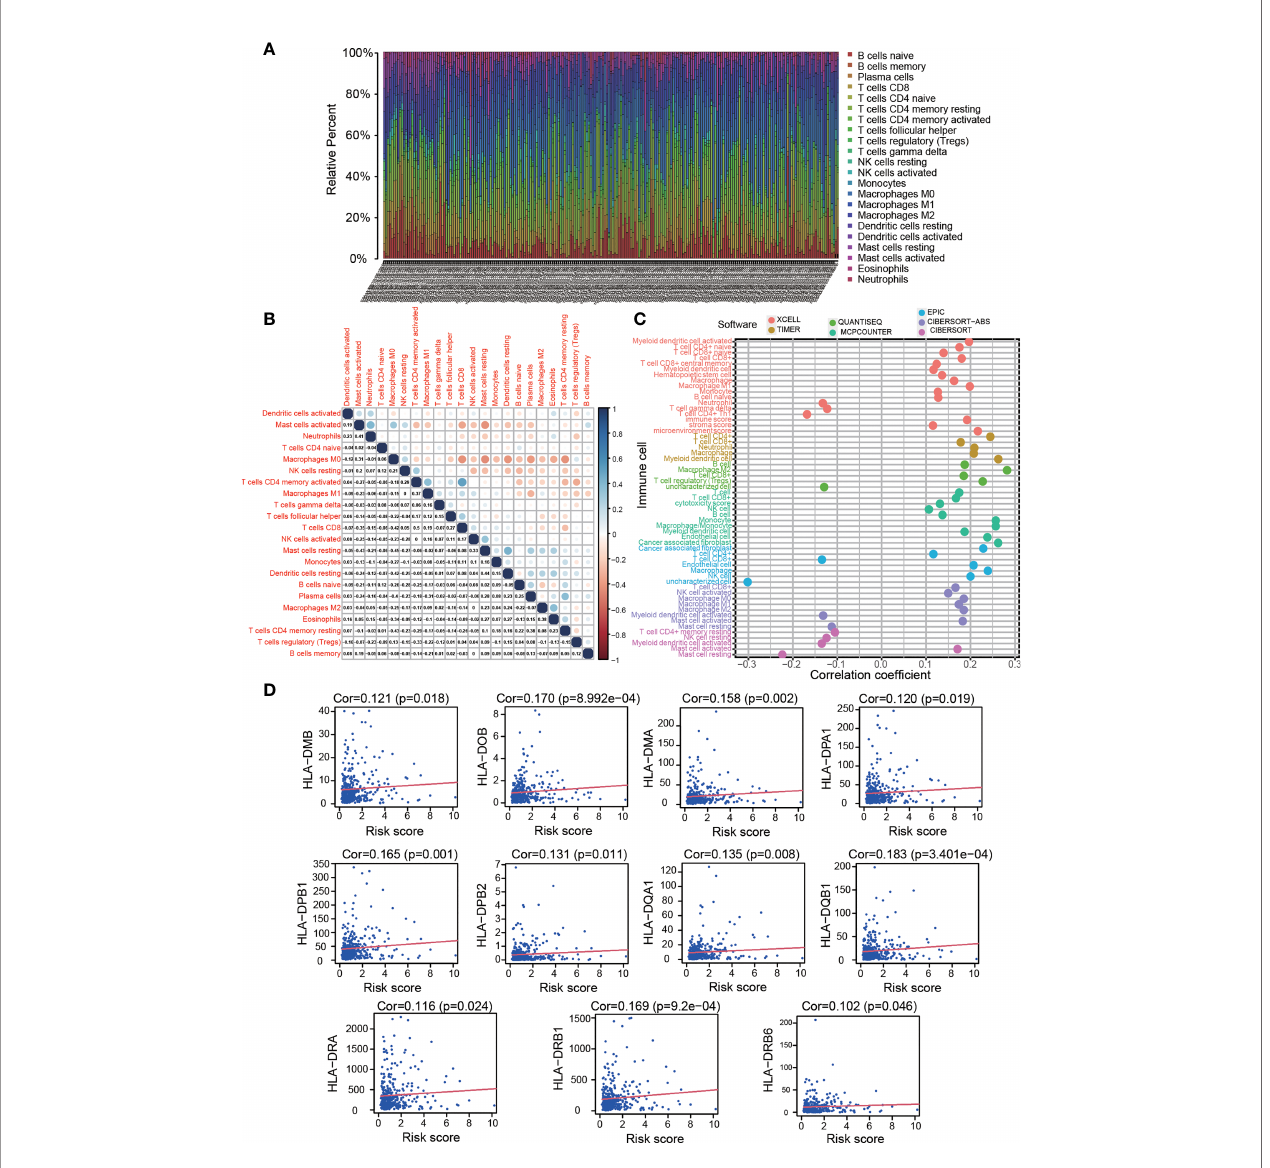
FIGURE 6 | Estimation of tumour-in fi ltrating cell proportion and HLA-D region gene expression by risk model. (A) Bar plot of the proportion of each immune cell type in the colon cancer patient cohort. (B) Correlations between the immune cell proportions in colon cancer. (C) Correlations between tumour-in fi ltrating immune cell proportions and risk score. High risk scores were more positively related to most tumour-in fi ltrating immune cells, such as macrophages, CD4+ T cells and CD8+ T cells, as shown by Spearman correlation analysis. (D) High risk scores were positively correlated with HLA-D region gene